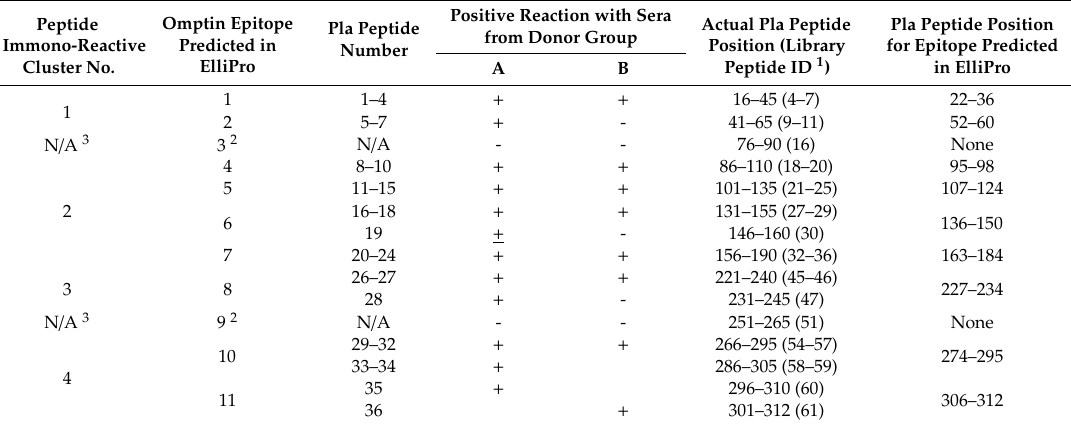
Table 2. Immunopositive Pla peptides reacted with sera obtained from vaccinated (group A) and unvaccinated (group B) donors